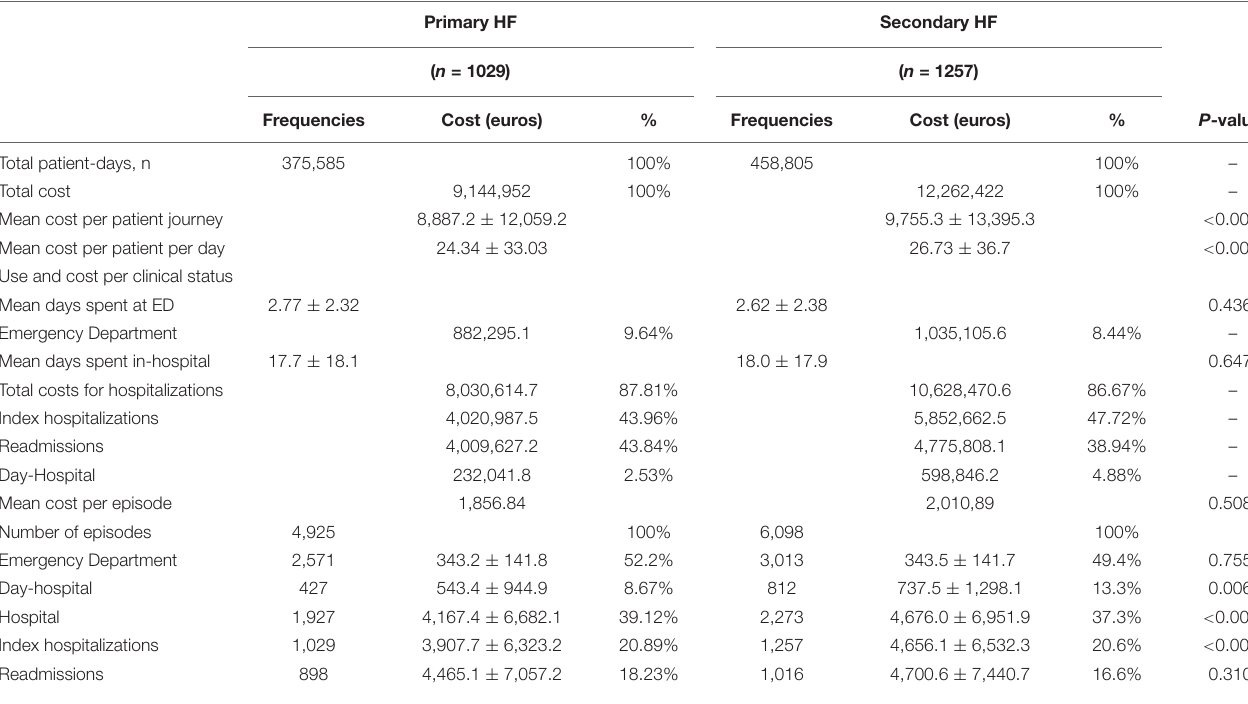
TABLE 2 | Costs per patient journey, clinical status and episode during the first year in hospitalized